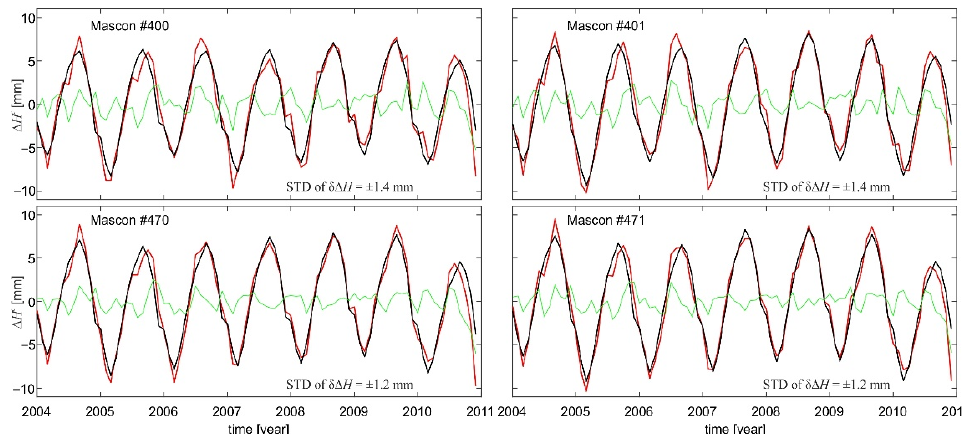
* ( )/ ) / ∆ H ∗ c ( t G ) ( black line ) and ∆ H SD ( t ) / ∆ H ∗ SD ( t ) models obtained models i i ) / ∆ H ∗ c ( t G ) and their corresponding i i